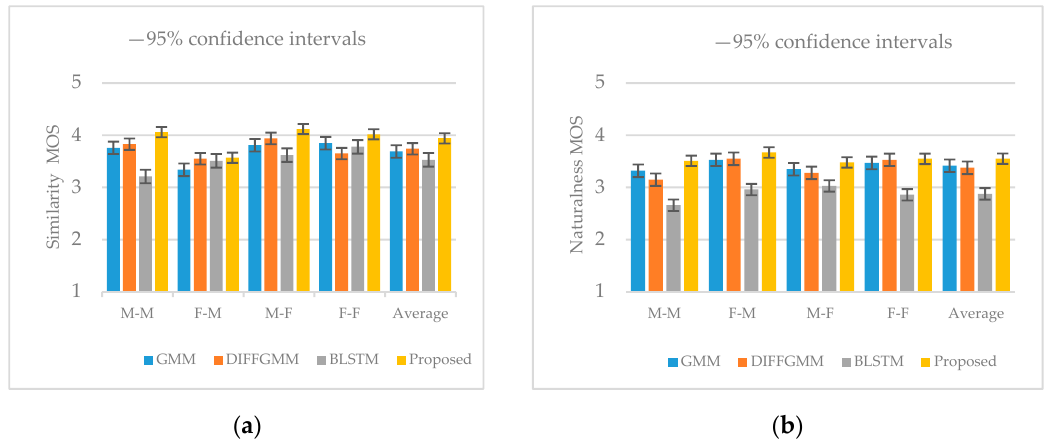
Figure 4. Results of the subjective evaluation for different methods on CMU ARCTIC (15dB babble added to source): ( a ) mean opinion score (MOS) for similarity with 95% confidence intervals and ( b ) MOS for naturalness with 95% confidence intervals.